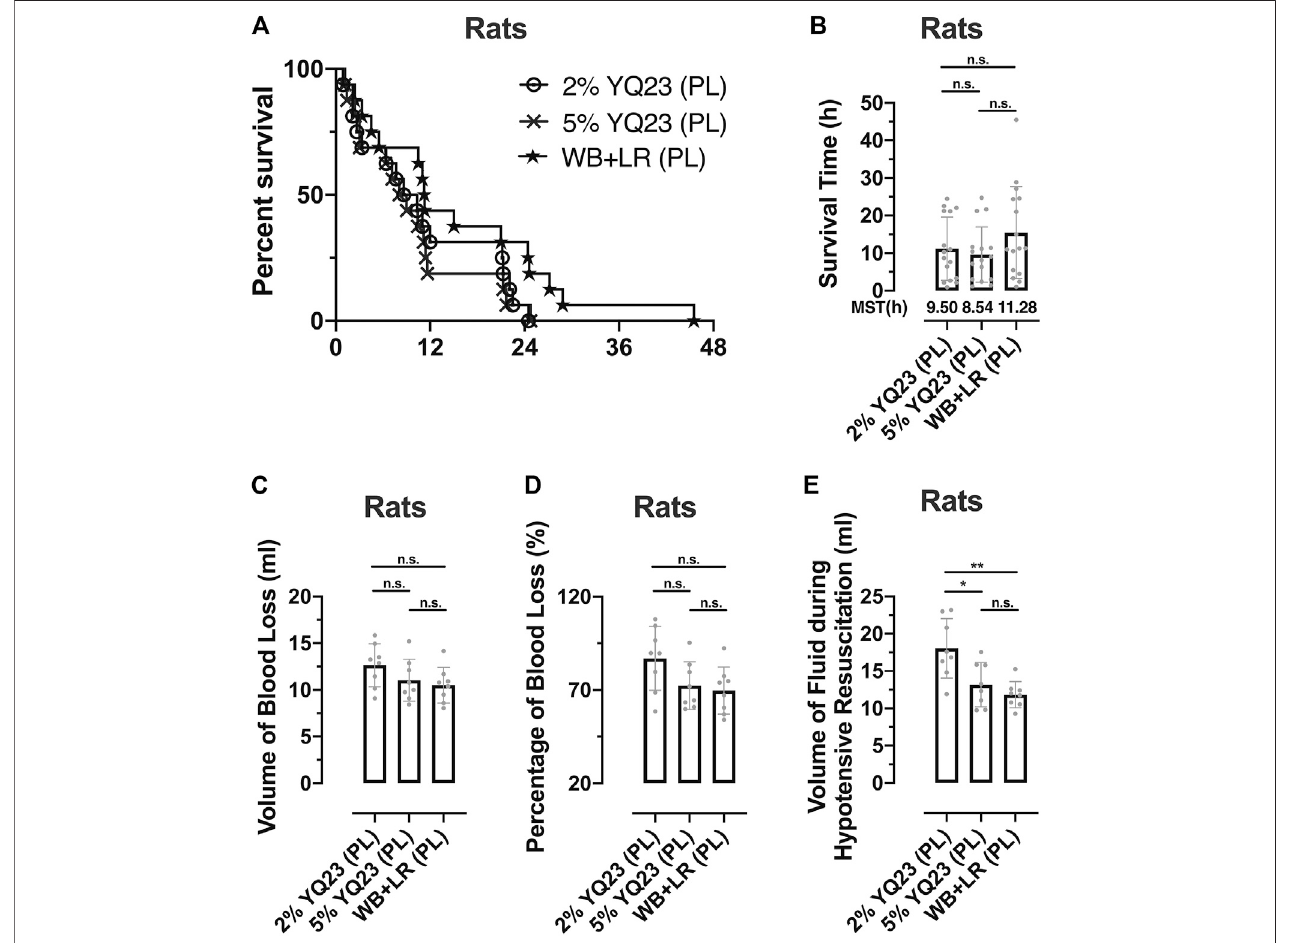
FIGURE 8 | YQ23 extended the Golden Hour for uncontrolled hemorrhagic shock. (A) , survival curve of rats received prolonged hypotensive resuscitation ( n (cid:1) 16/group); (B) ,thesurvivaltimeofratsreceivedprolongedhypotensiveresuscitation( n (cid:1) 16/group); (C) ,thevolumeofbloodlossinratswithprolongedhypotensive resuscitation ( n (cid:1) 8/group); (D) , percentage of blood loss in rats with prolonged hypotensive resuscitation ( n (cid:1) 8/group); (E) , volume of fl uid demand in rats received prolonged hypotensive resuscitation ( n (cid:1) 8/group). LR, Lactate Ringer ’ s solution; WB, whole blood; MST, median survival time; PL, prolonged hypotensive resuscitation. * p < 0.05, ** p < 0.01, n. s., not signi fi